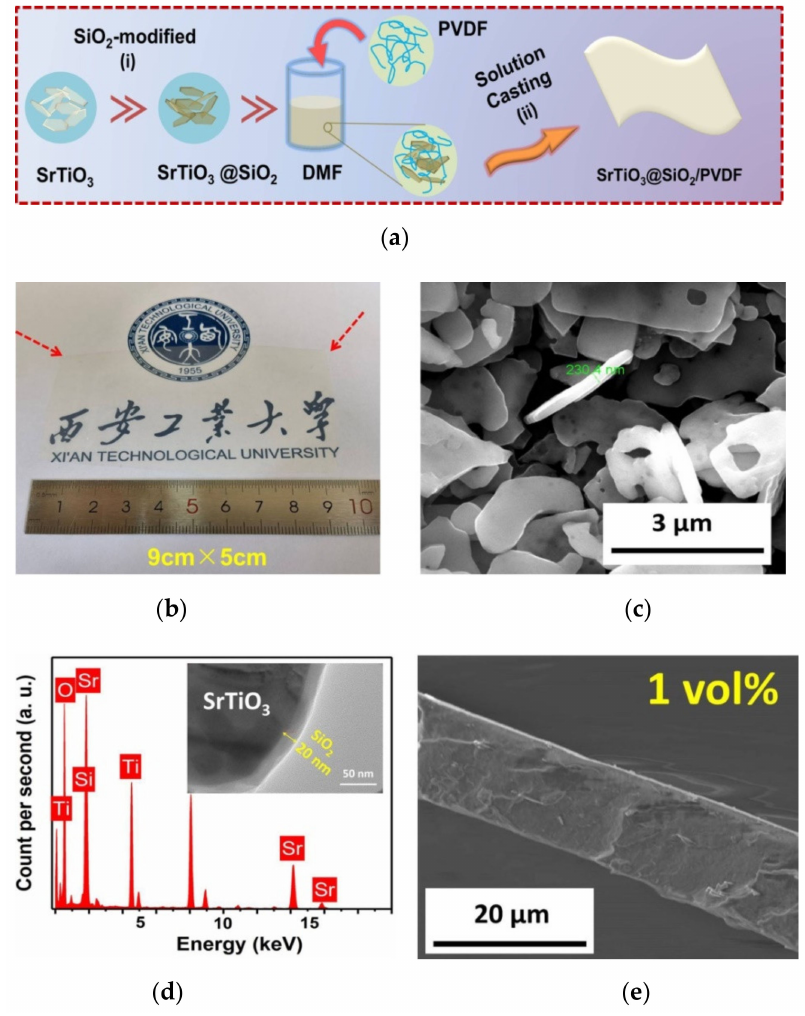
Figure 1. ( a ) Schematic illustration of the synthesis of plate-like SrTiO 3 @SiO 2 powders and the manufacturing process of composites by solution casting process. ( b ) Sample optical image of a composite with a 1 vol% SrTiO 3 @SiO 2 platelet. ( c ) SEM image of SrTiO 3 @SiO 2 platelets. ( d ) EDS spectrum of SrTiO 3 @SiO 2 platelets, inset shows TEM morphology of core–shell structure platelets. ( e ) Cross-section SEM images of composites with 1 vol%